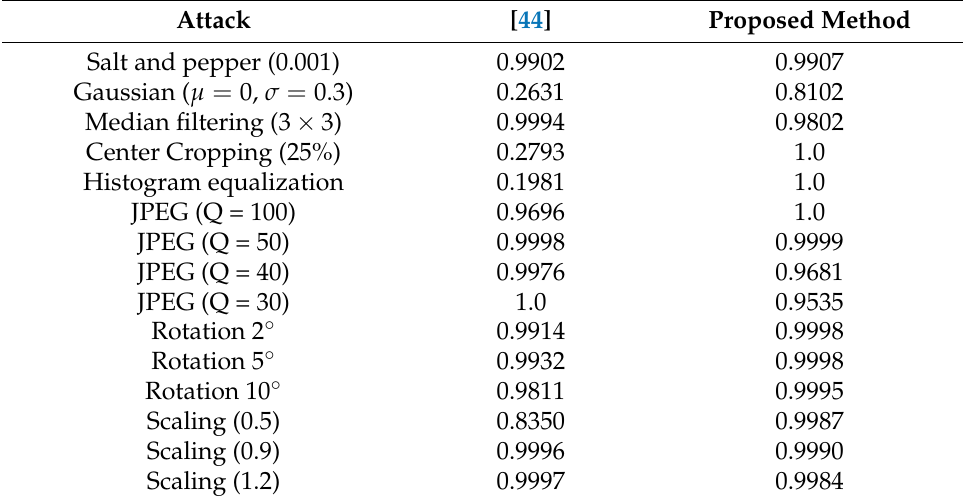
Table A3. Robustness comparison with [44] measured in terms of NC for Lena.